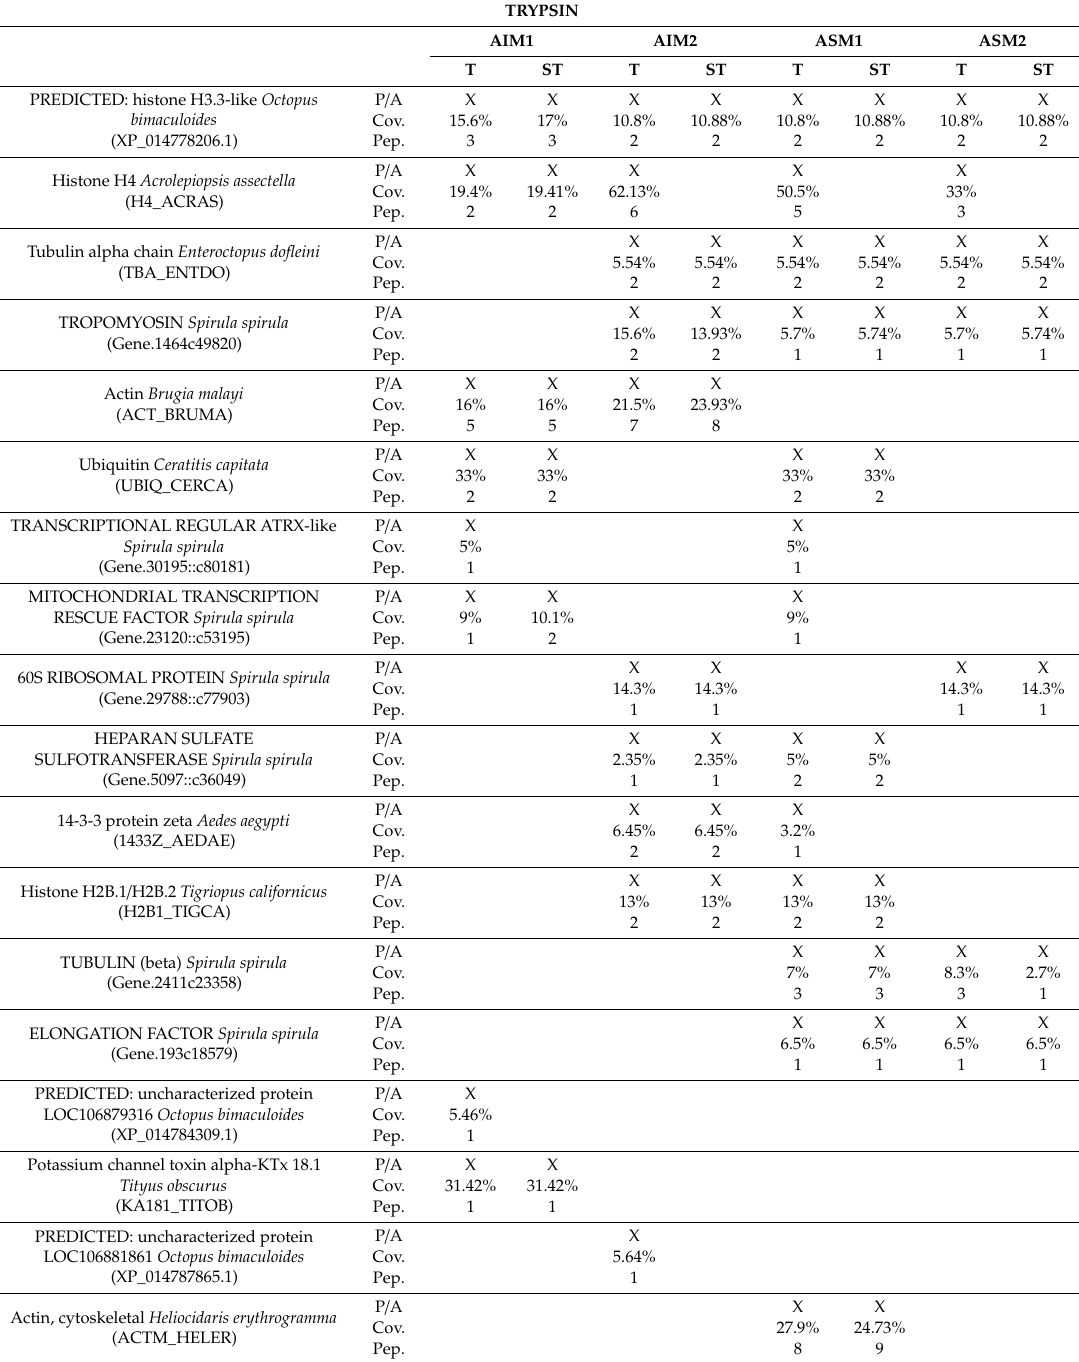
Table 6. Main protein hits obtained by proteomics, according to two stringencies: trypsin (T), and semi-trypsin (ST). For each protein hit, the presence is indicated by “X”, as well as the protein coverage (Cov.) and the number of peptides (Pep.) that allow the protein identification, for each of the four extracts. A complete version of this table is available as Supplementary Table